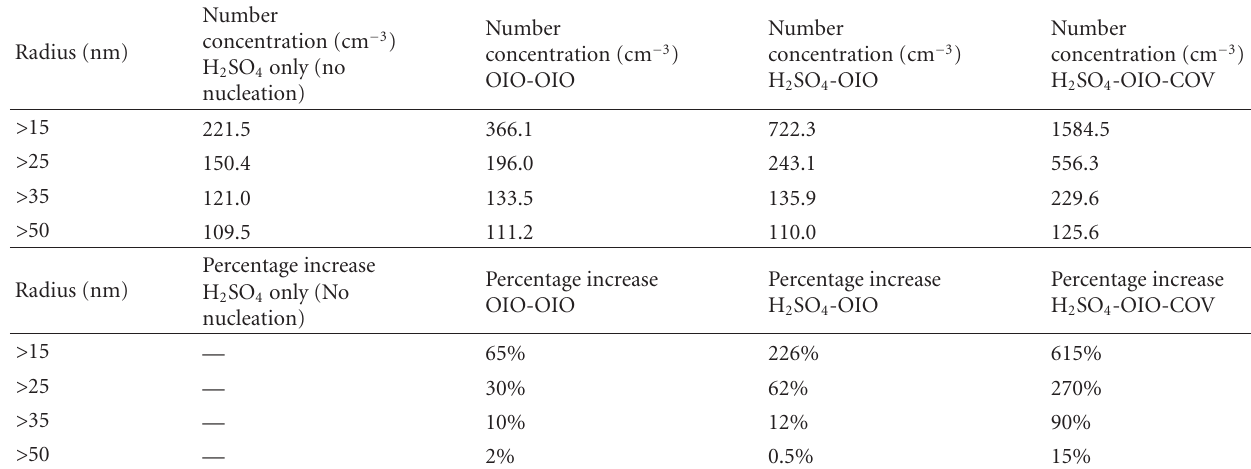
Table 1: Comparison of absolute particle number concentrations increases for particles of radii more than 50, 35, 25, and 15nm, using the di ff erent nucleation schemes, taken over 48 hours at vapor concentrations of 6 × 10 6 molec · cm − 3 for the sulphuric acid and iodine along with 12 × 10 6 molec · cm − 3 for the nonnucleating organic